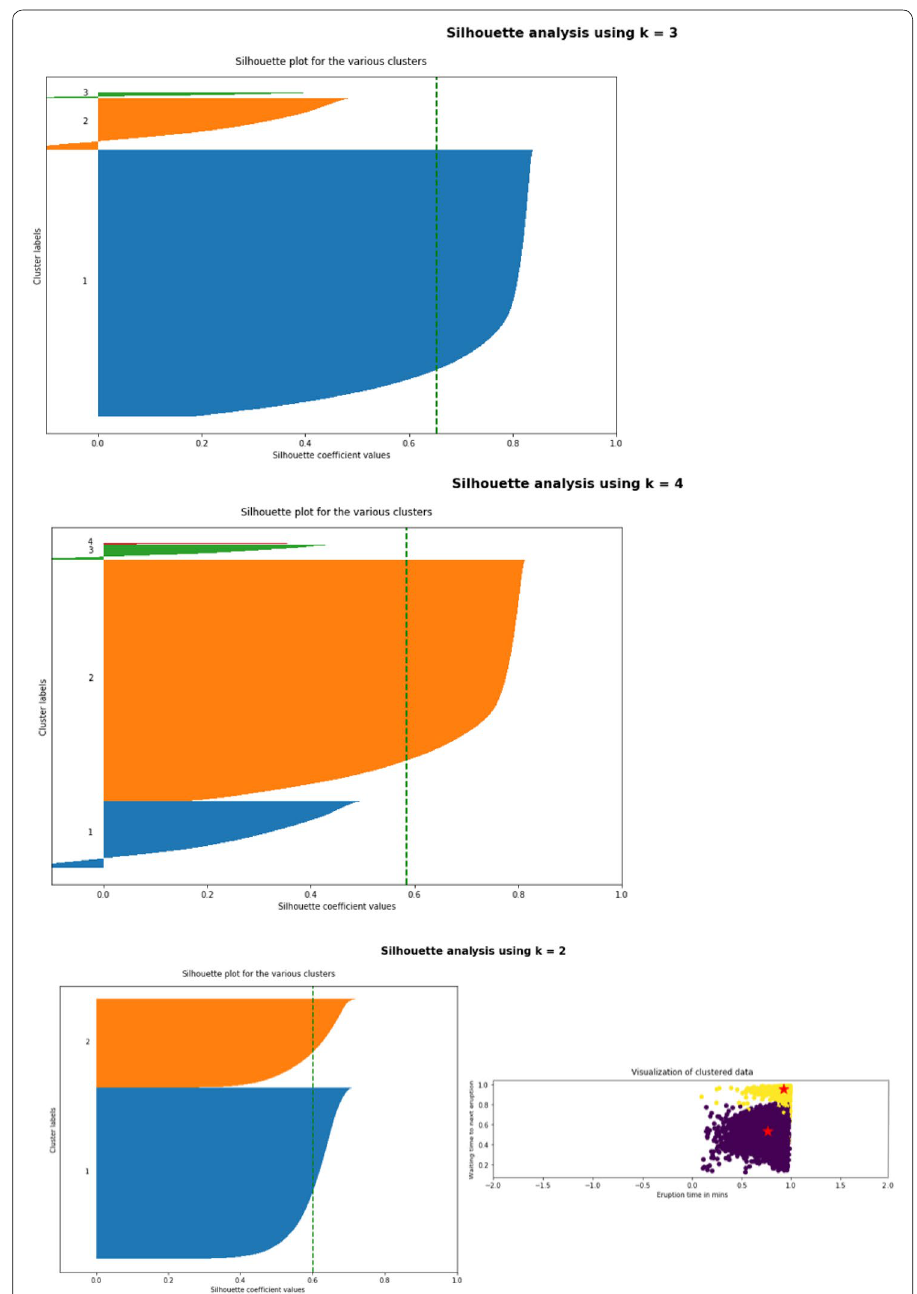
Fig. 10 Average Silhouette Score for different